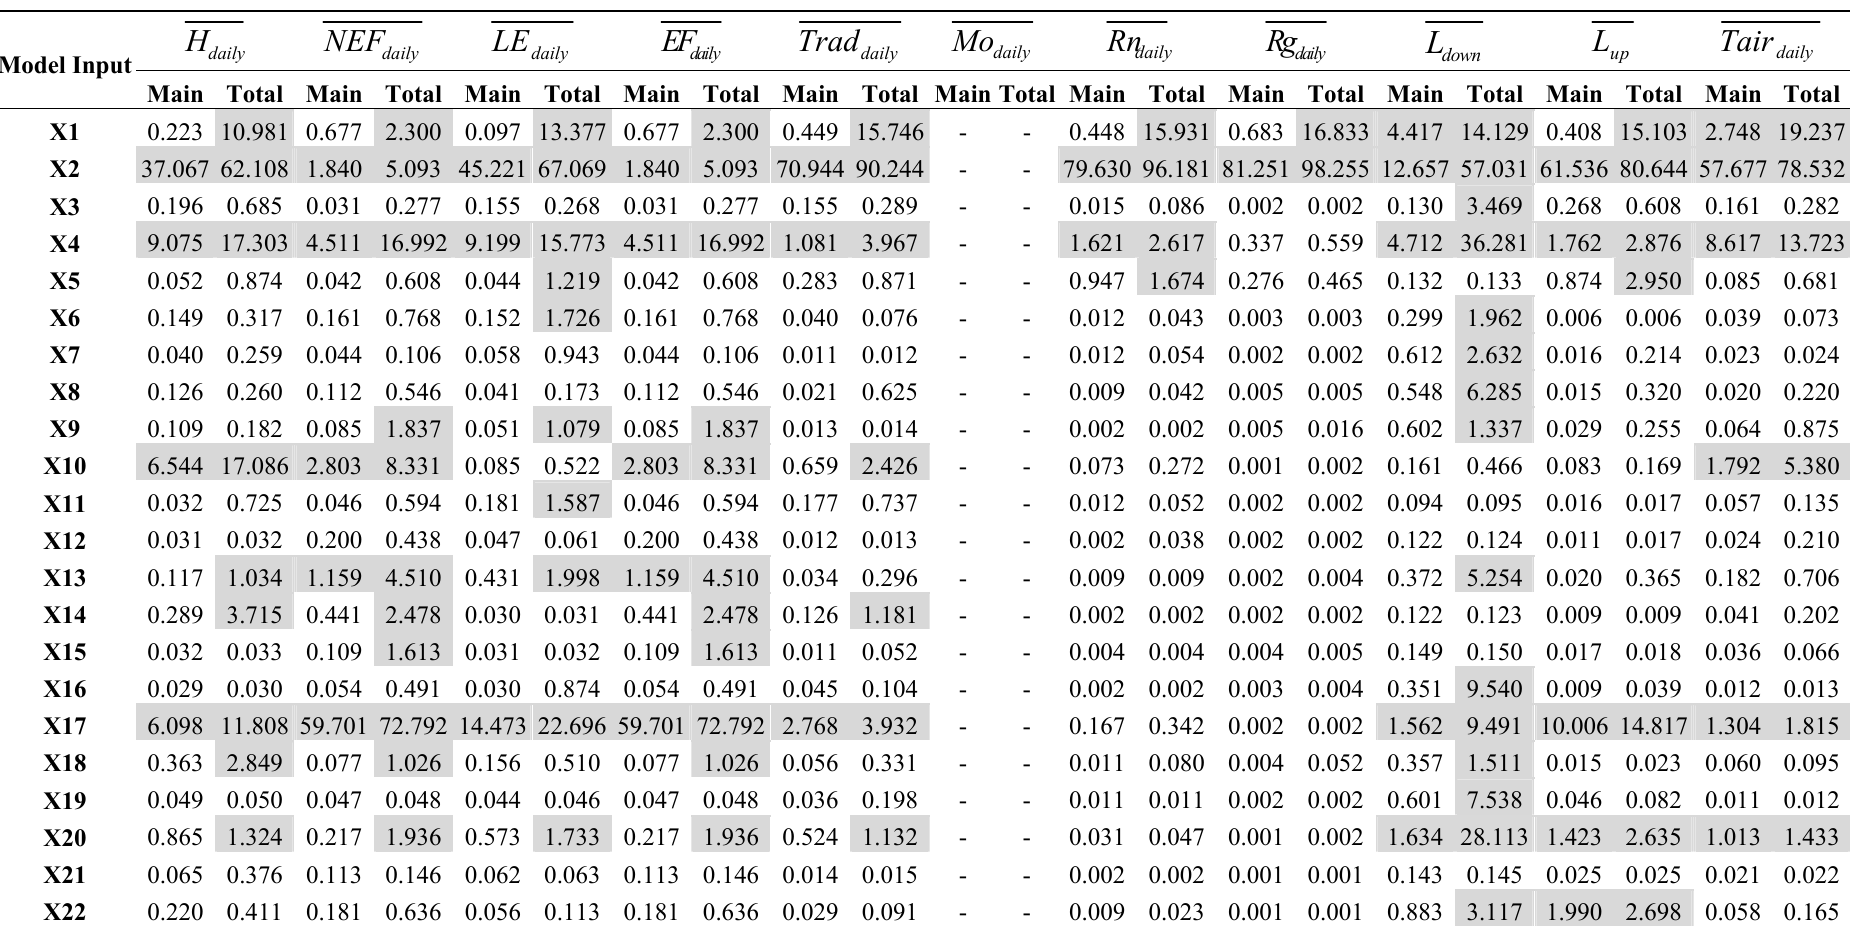
Table 4. Summarized results from the implementation of the BACCO GEM-SA method on the different outputs simulated by SimSphere using uniform PDFs at 07:30. Computed main (Main) and total effect (Total) indices by the GEM tool (expressed as %) for each of the model parameters are shown, whereas the last three lines summarise the percentages of the explained total output variance of the main effects alone (ME), the 1st order interactions only (1st) and the 2nd or higher order interactions only (>1st). Input parameters with a variance decomposition of greater than 1% are